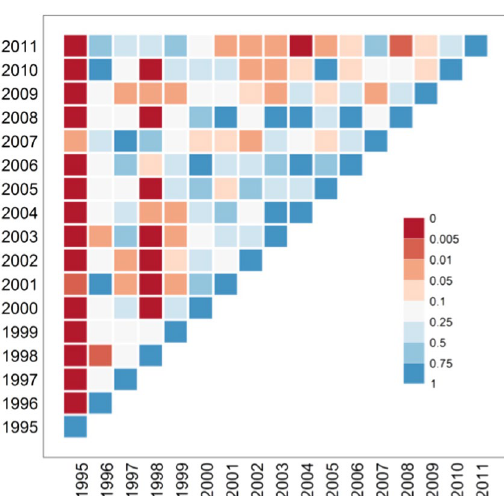
Figure 4. Matrix of p values from Hotelling’s T 2 tests. Under H 0 the T 2 statistic follows a central F distribution. The test is described in the Methods section. We compare the incidence rates of TB among resident Singaporeans, for planning areas of Singapore for a pairs of years. The colour red implies significant statistical difference in overall spatial risk between the two years while blue implies no